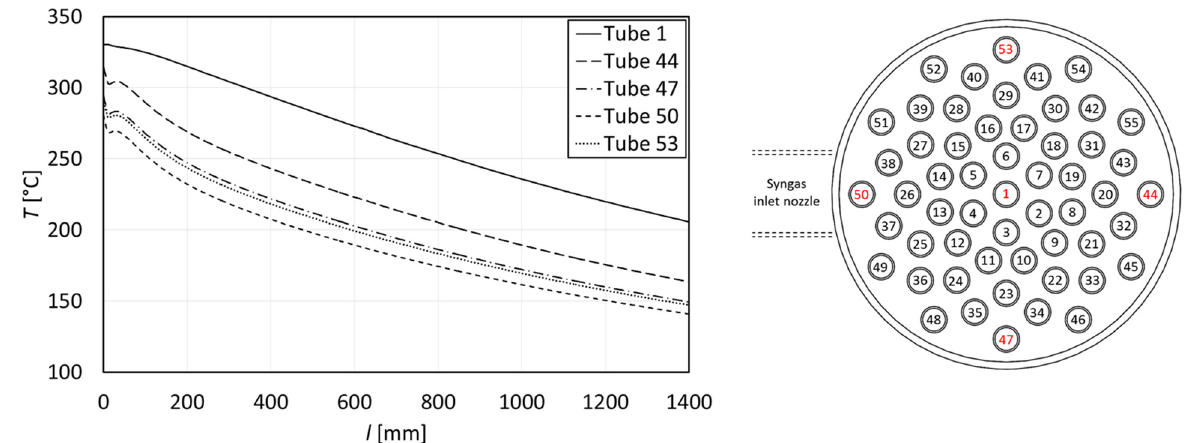
Figure 8. Evolution of syngas temperature along the tube axis for five characteristic tubes (location in the bundle highlighted in red in the schematic on the right).